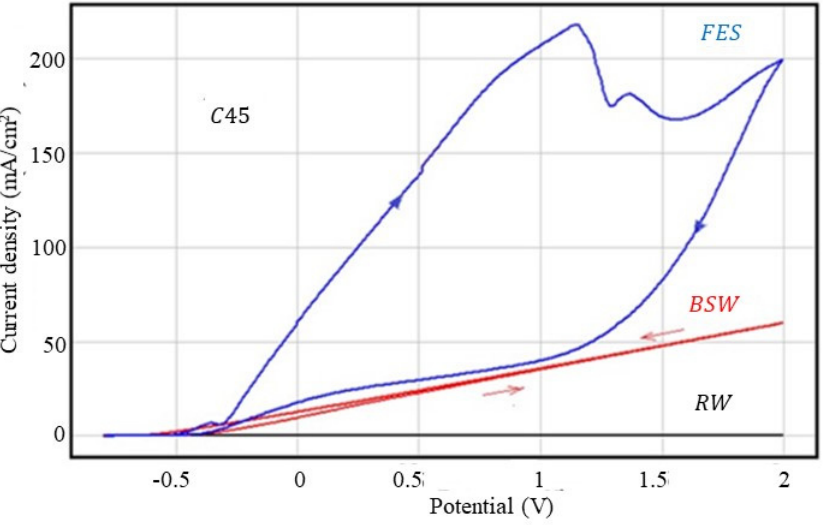
Table 5. Stimulated corrosion parameters for the C45 sample in the three corrosive environments.